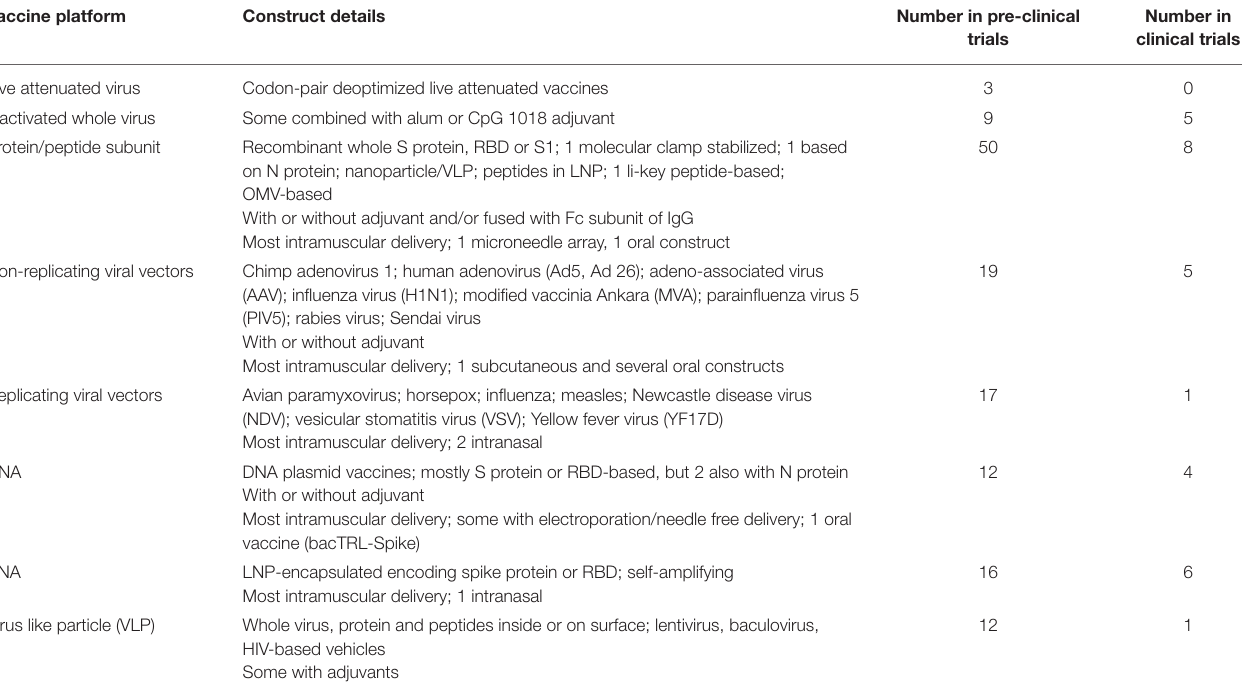
TABLE 1 | Vaccines approaches being taken and the number of candidate vaccines in clinical and pre-clinical trials (20 August 2020). Vaccine